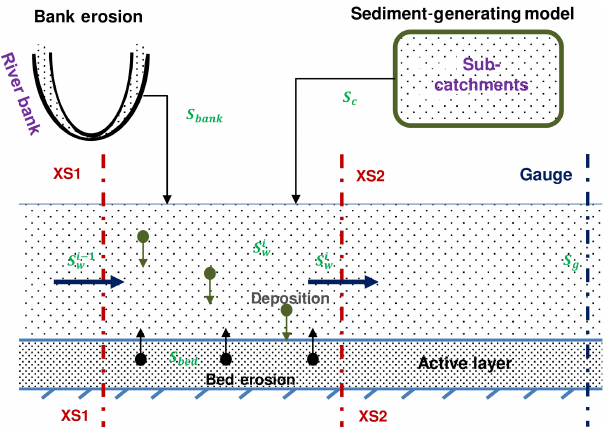
Figure 3. In-stream processes of the river suspended-sediment transport model considering deposition, bed erosion, bank erosion, and input from the catchment. XS1 and XS2 are the two cross sec- tions bounding a cell in a finite-volume scheme. S c and S bank are sediments from the catchment and bank erosion. S bed indicates the bed sediment mass. S i w stands for the concentration of suspended sediments in the i th cell. S g is the suspended-sediment concentra- tion at a river